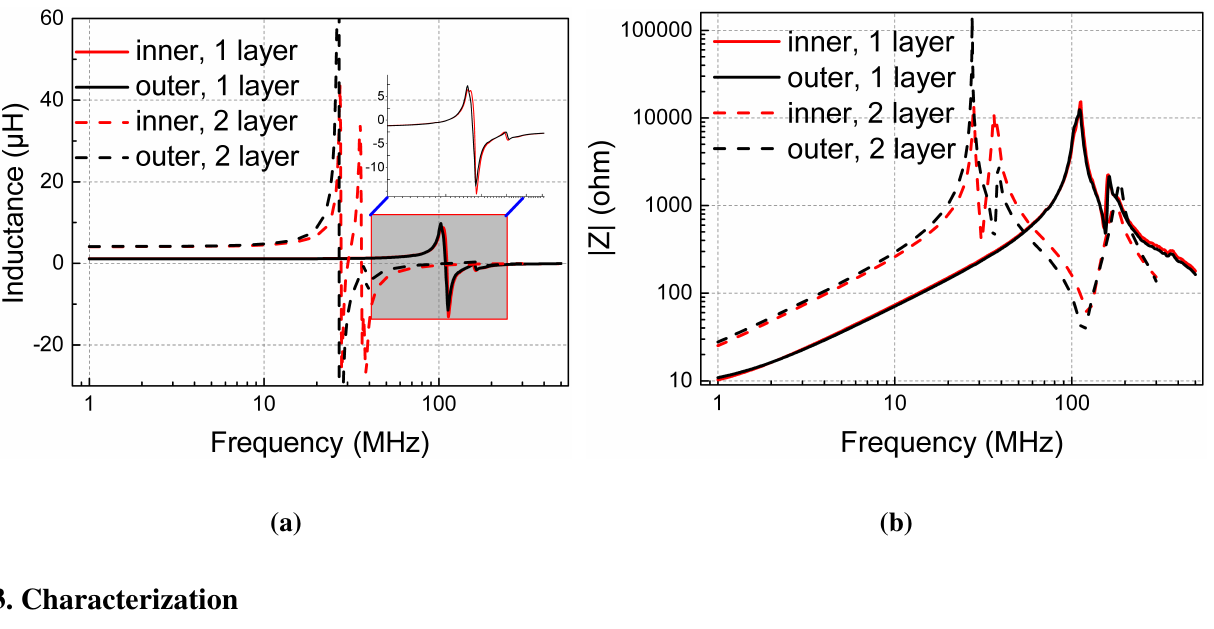
Figure 2. ( a ) Inductance and ( b ) impedance measurement of coils with one layer and two layers of windings. The number of windings in the double-layer coils is twice as in the single-layer